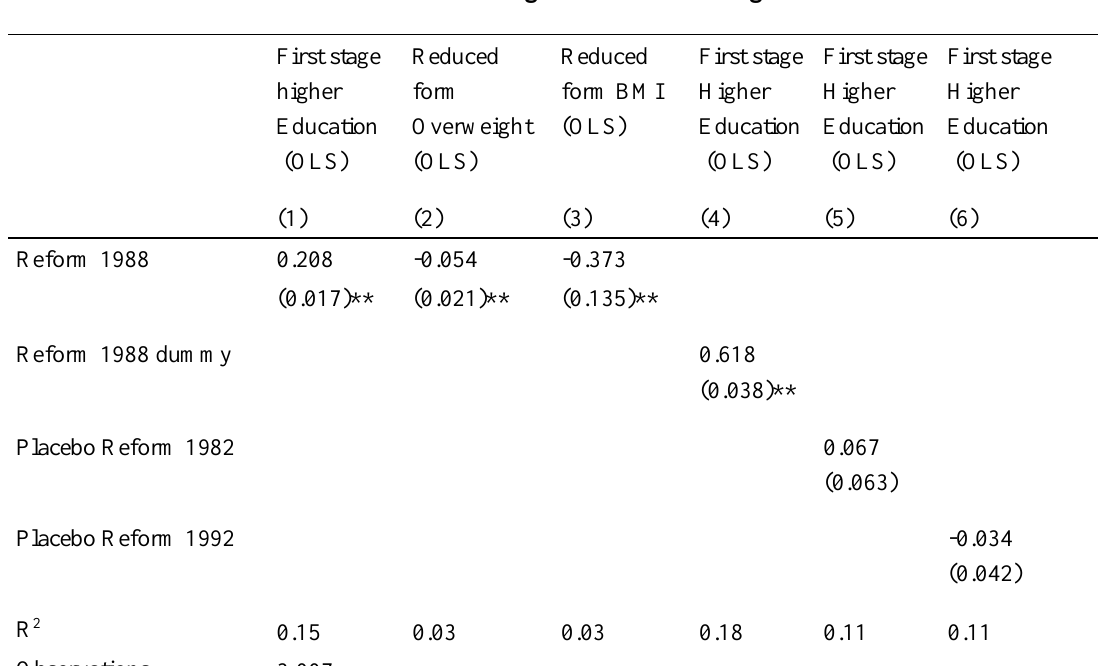
Test of the instrument. First stage results for higher education and reduced form results for overweight and BMI among all